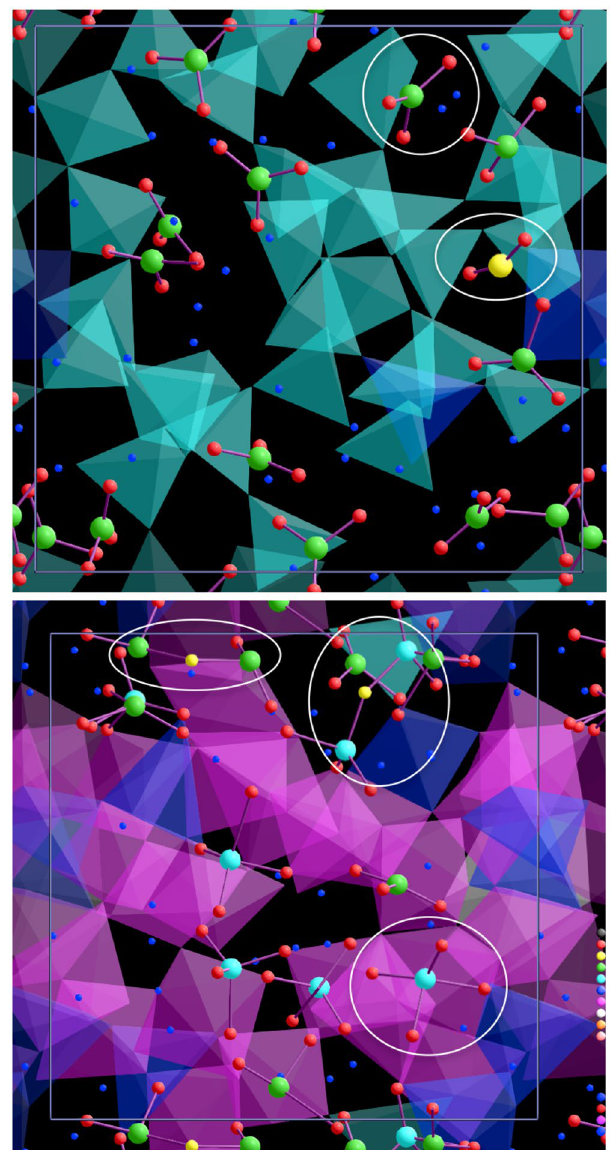
Figure 2. Visualization snapshots of the melt structure. Various CO n species (marked with ellipses) and the Si-O tetrahedra (cyan), pentahedra (blue), and octahedra (pink) are present in the melt at the zero pressure and 2200 K ( top ), and 92 GPa and 4000 K ( bottom ) for 16.1 wt.% concentration. C 2 O 5 and C 2 O 7 can be seen in the compressed melt. Tiny blue spheres represent Mg atoms in both